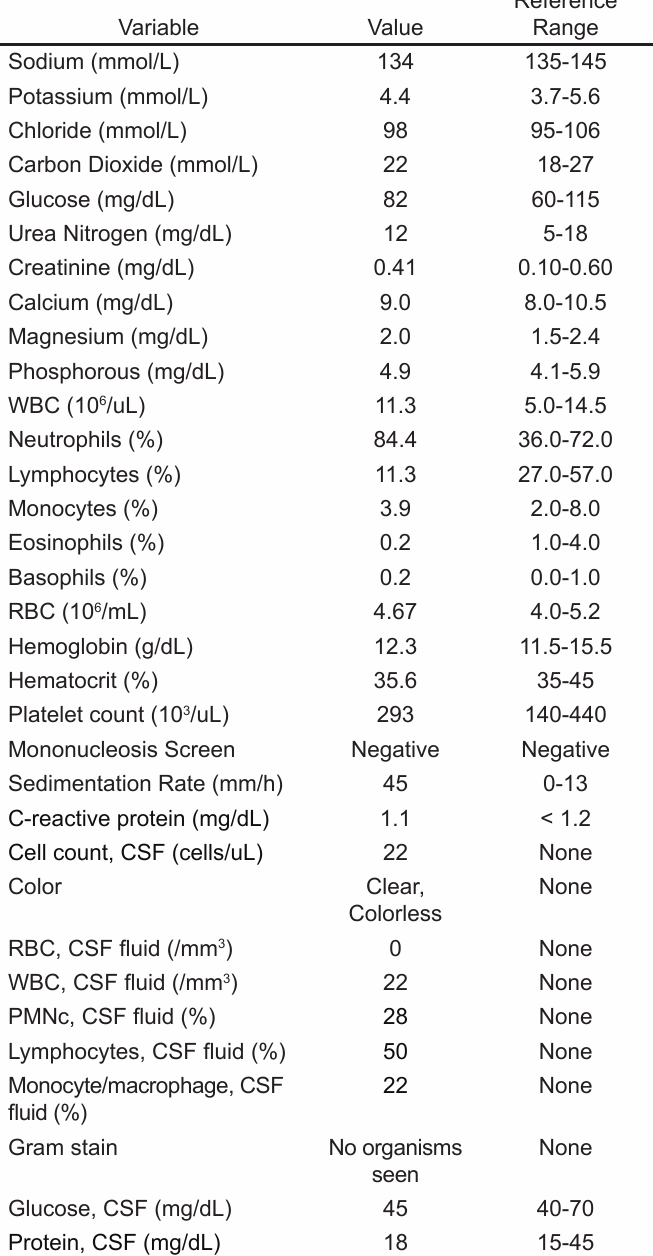
Table. Laboratory data of six-year-old child diagnosed with neuroborreliosis.